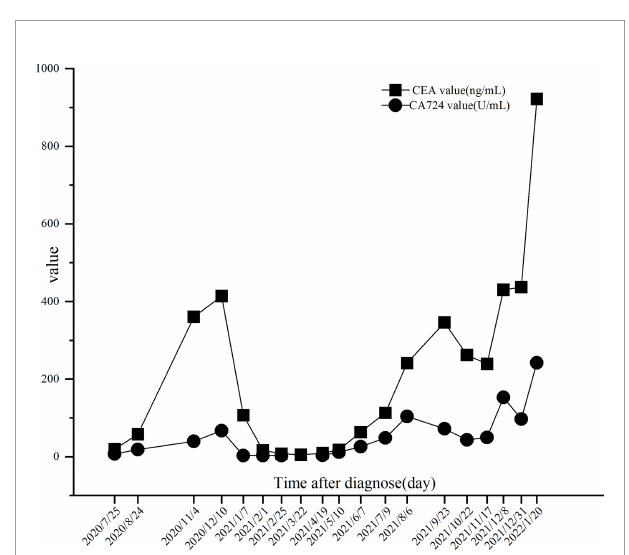
FIGURE 3 | Trends of CEA and CA724 levels. The CA724 level was reduced to normal on 07 January 2021 after 2 cycles of PRaG therapy. The CEA level was decreased to normal on 22 March 2021 after 4 cycles of PRaG therapy. There was a fl uctuating increase in both biomarkers from 6 August 2021 to 3 1 December 2021, but the disease remained stable after CT evaluation. On 20 January 2022, a multifold increase in the two biomarkers was detected, at which time the patient was assessed as progressive disease (PD) by CT